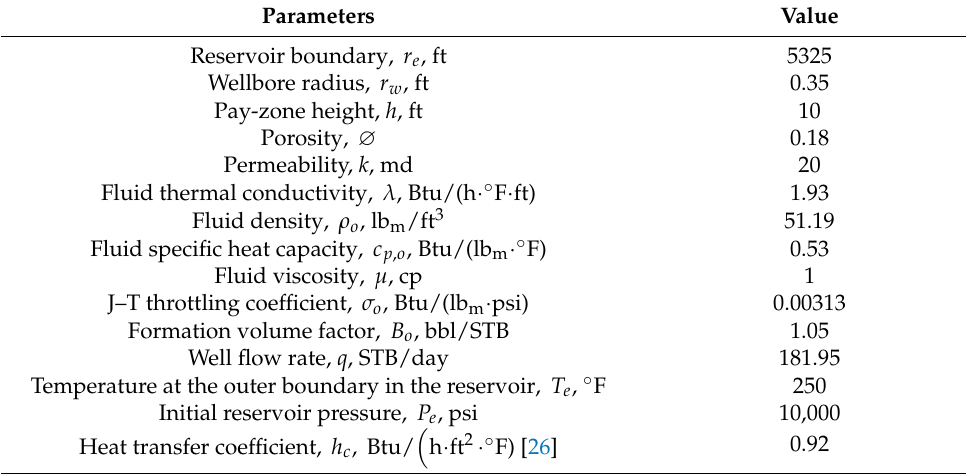
Table 2. Well, formation, and fluid data (STB: barrel at the standard condition) [28]. Parameters Value Reservoir boundary, r e , ft